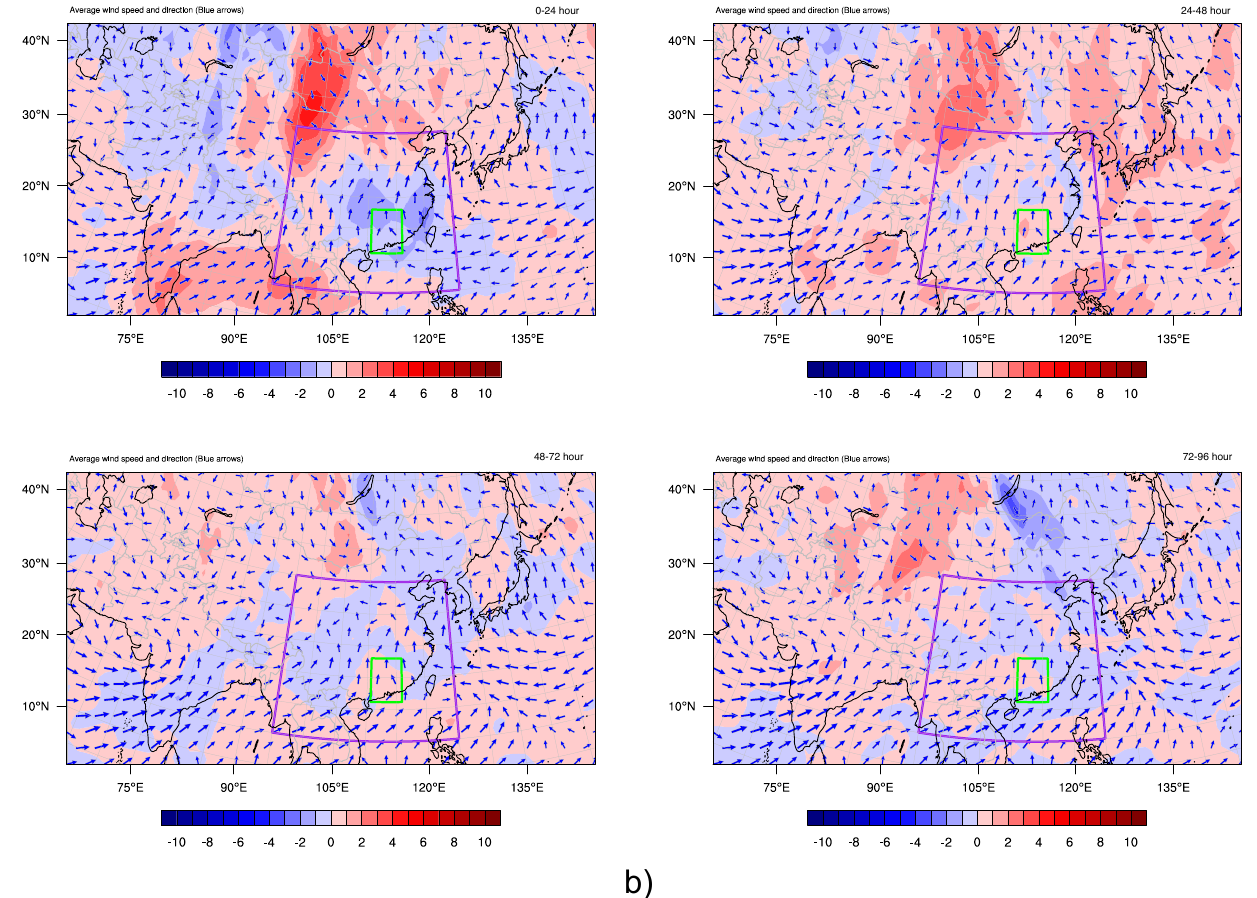
Figure 12. The contour plots show the difference of the ( a ) 2 m temperature and ( b ) 2 m relative humidity at four Figure 5.7: The contour plots show the di↵erence of the (a) 2m temperature and (b) different time periods, (1) 0–24 h, (2) 24–48 h, (3) 48–72 h, and (4) 72–96 h, between the 3DVAR_SUMMER and the 2m relative humidity at four di↵erent time periods, (1) 0-24 hours, (2) 24-48 hours, CONTROL_SUMMER in the 27 km domain. The blue arrows indicate the monthly averaged wind speed and direction of (3) 48-72 hours, and (4) 72-96 hours, between the 3DVAR SUMMER and the CON- CONTROL_SUMMER to show the general wind pattern of this season. The purple box is where the evaluation observations for evaluating the 27 km domain are located (Figure 3) and the green box is where the evaluation observations for evaluating TROL SUMMER in the 27km domain. The blue arrows indicate the monthly averaged the 3 km domain are located (Figure wind speed and direction to show the general wind pattern of this season. The purple box is where the observations for evaluating the 27km domain are located and the green box is the 3km domain.